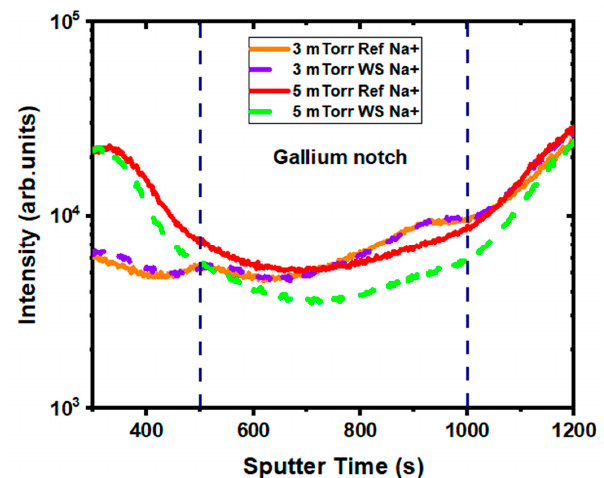
Figure 10. Detailed SIMS depth profile in the bulk of copper indium gallium diselenide (CIGS) of Na ⁺ in the reference (solid) and 24 h water-soaked (dash) samples, for the 3 mTorr and the 5 mTorr experimental set.